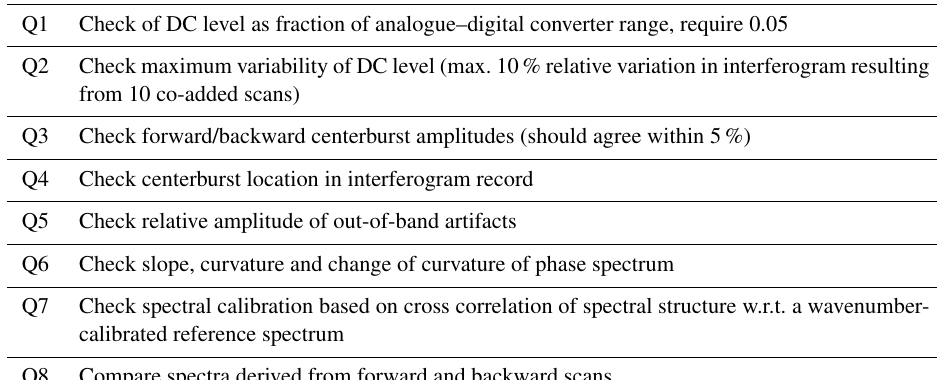
Table 1. This table summarizes the quality filters applied in the FORTRAN-based preprocessing tool. Q1 Check of DC level as fraction of analogue–digital converter range, require 0.05